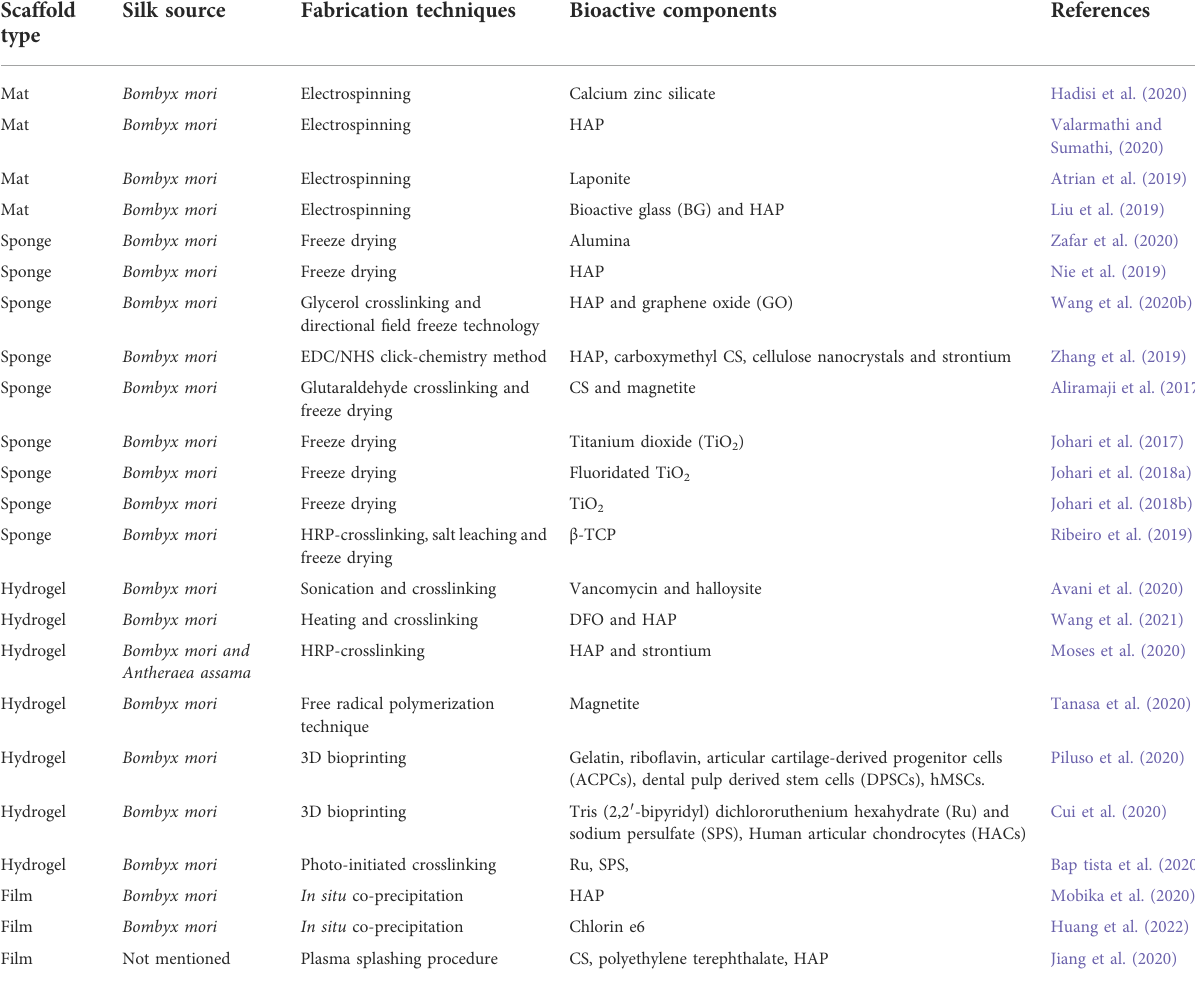
TABLE 1 Summary of fabrication techniques of SF scaffolds for bone regeneration. Scaffold